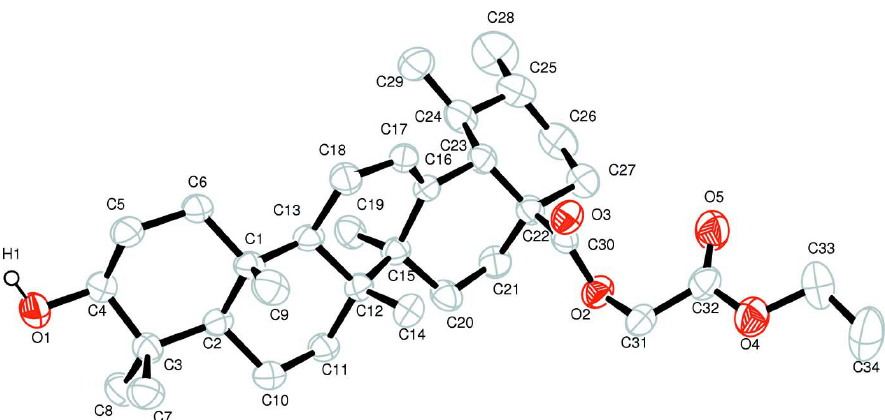
Figure 1 The molecular structure of the title compound, with displacement ellipsoids drawn at the 30% probability